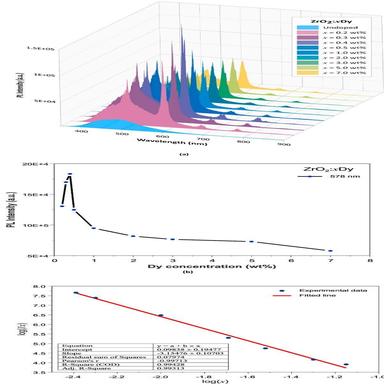
(a) PL emission spectra of ZrO2 with varying Dy3+ concentrations (b) variations in the yellow emission intensity with its peak at 578 nm as a result of Dy3+ doping (c) Plot of log(I/x) versus log(x) for the 4 F9/2→ 6 H13/2 transition from Dy3+ ions in ZrO2:xDy3+ phosphors. (For interpretation of the references to color in this figure legend, the reader is referred to the Web version of this article.)